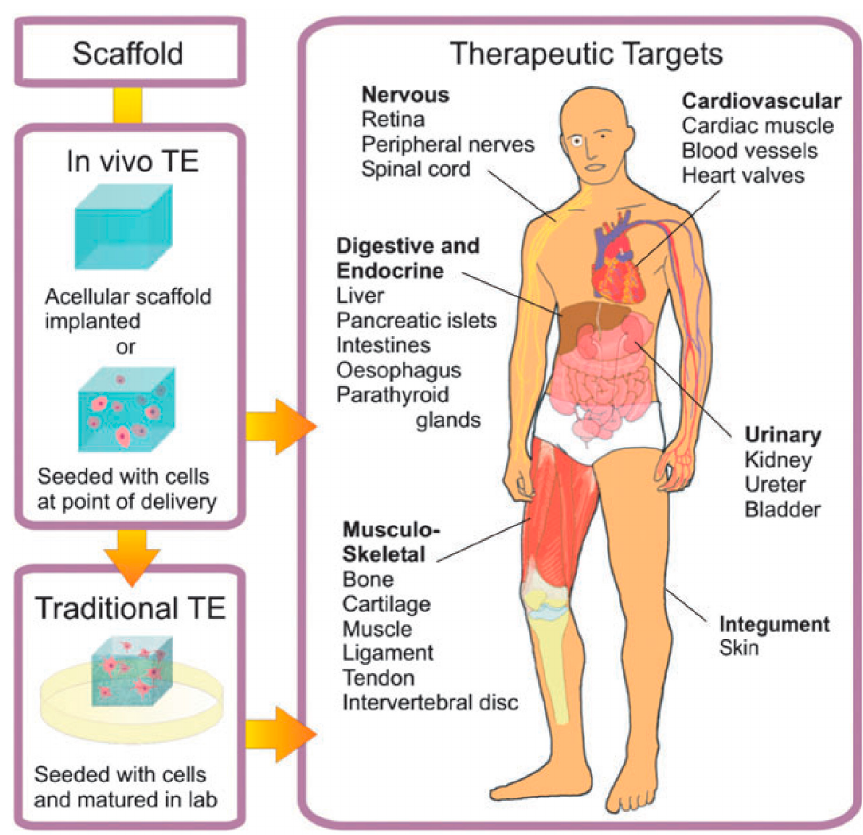
Figure 1. Scheme of the approaches employed for tissue engineering (TE). In traditional TE (in vitro TE), cellularized scaffolds are matured in vitro and then introduced into the patient. For in vivo TE, the scaffold is implanted directly into the patient. Reproduced with permission from [8].